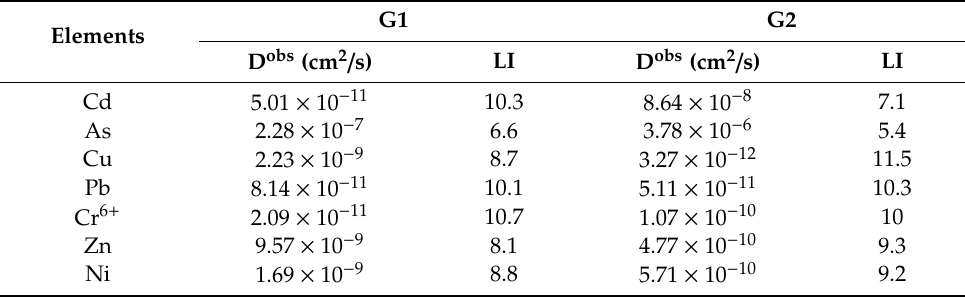
Table 5. Observed di ff usivity and leachability index of